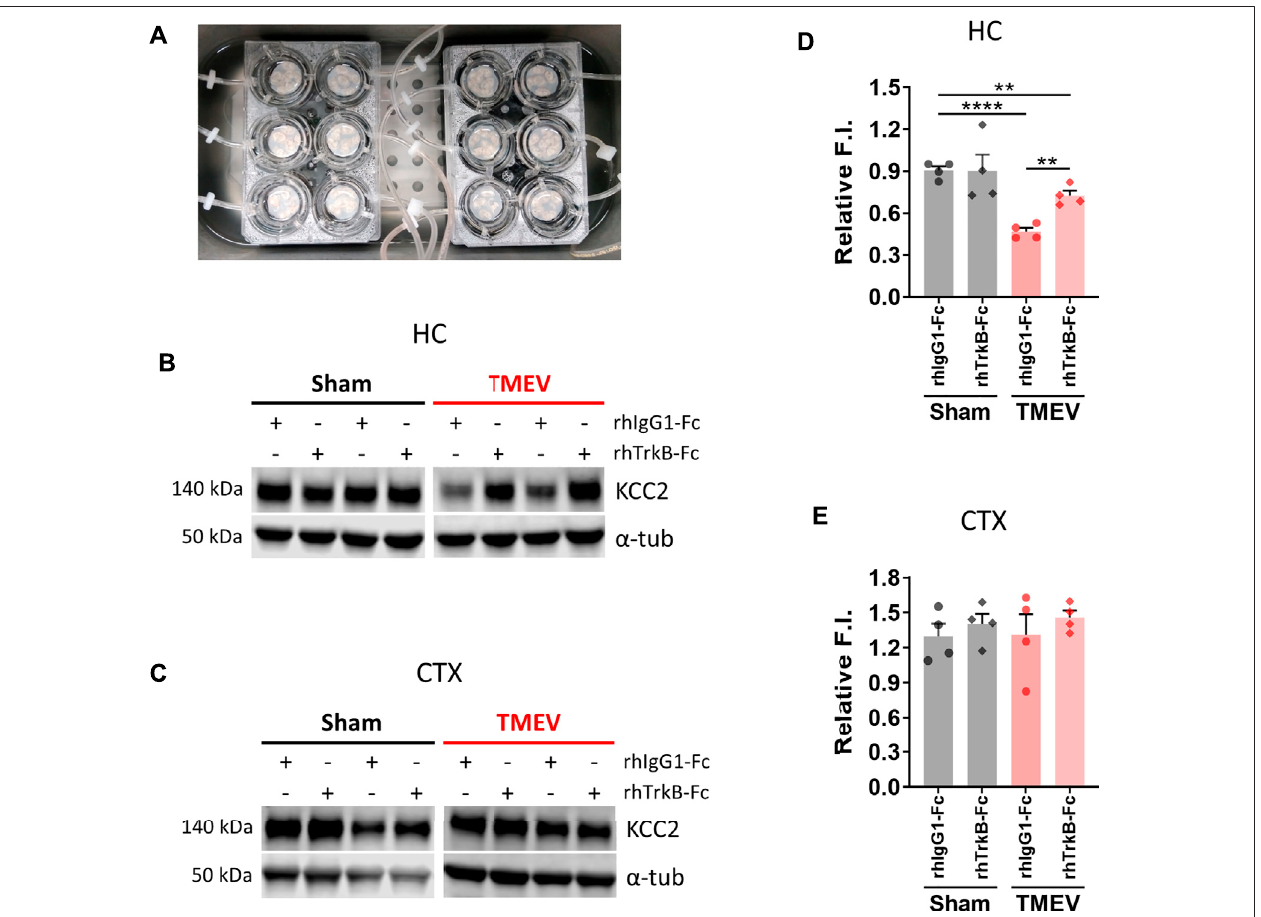
FIGURE4| InhibitionofBDNFincreasestheexpressionofKCC2inhippocampalslicesfrommiceduringTMEV-inducedacuteseizureperiod. (A) Acutebrainslices (300 µmthickness)fromsham-orTMEV-infectedmiceweretreatedwithrhTrkB-FcorrhIgG1-Fc(250 ng/mlinACSF)for4.5 hat37 Cundercontinuouscarbogenation (95%oxygen,5%carbondioxide)conditionbeforedissectingouthippocampus(HC)andcortex(CTX). (B – C) RepresentativeimmunoblotsshowthedetectionofKCC2 and α -tubulin in hippocampi (B) and cortex (C) isolated from acute brain slices under different treatment conditions for both groups of mice. (D – E) Fluor intensity (F.I.)ofKCC2blotswerenormalizedtotheF.I.of α -tubulinblotsfromthesamesamplestocomparetherelativeF.I.betweenthesham-andTMEV-infectedslicestreated either with rhIgG1-Fc or rhTrkB-Fc. Statistics: One-way ANOVA, Tukey ’ s multiple comparisons test; n = 4 mice per group; ** p < 0.01, **** p < 0.0001.